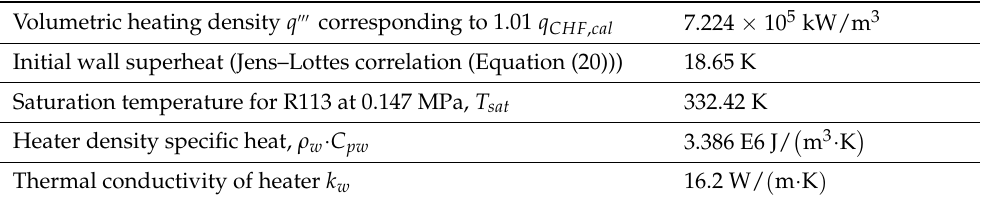
Table 3. Other information used in the calculation of surface temperature change at the